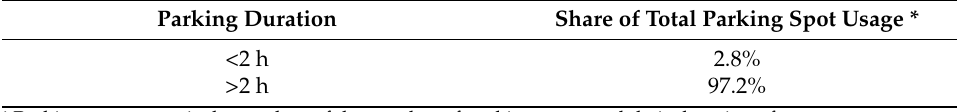
Table 3. Share of total parking spot usage by duration.